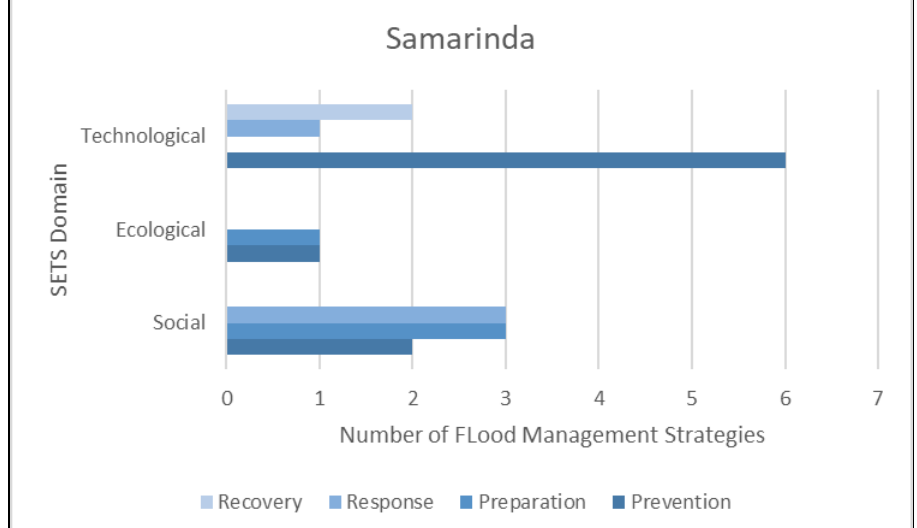
Figure 6. Flood Resilience Phase for SETS domains in Samarinda (Source: authors) .